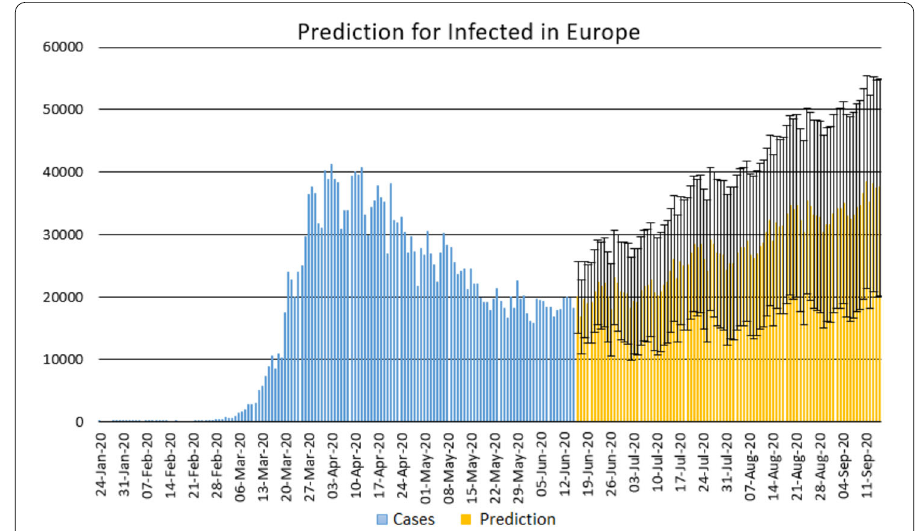
Figure 13 Prediction for the infected in Europe using Forecast Sheet